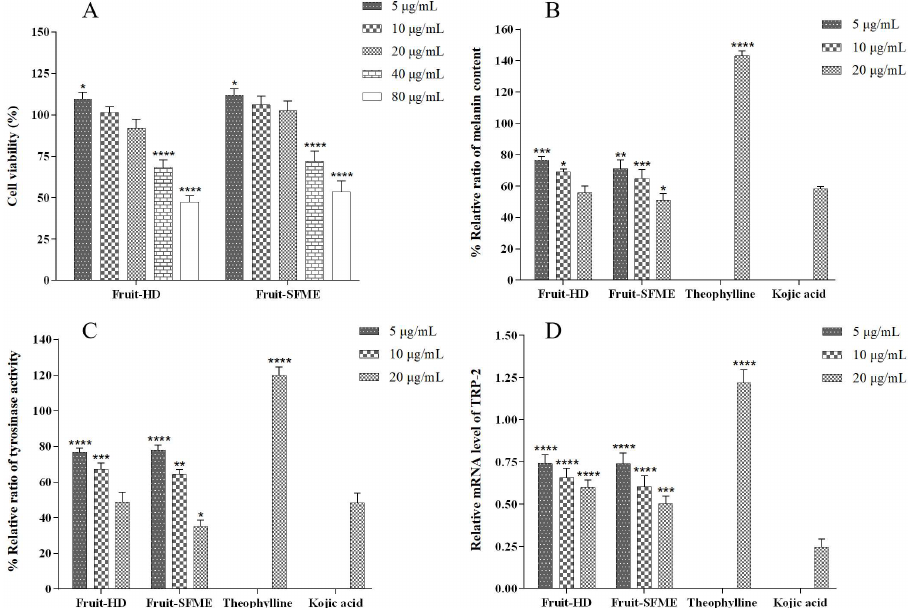
Figure 7. Melanogenesis assay in B16-F10 melanoma cells: ( A ) cytotoxicity assay in B16-F10 melanoma cells treated with L. cubeba fruit essential oils at 5–80 µ g/mL. The asterisk * indicates a significant difference from the control (* p < 0.05, **** p < 0.0001); ( B ) percentage of relative ratio of melanin content, ( C ) tyrosinase activity, and ( D ) relative mRNA level of TRP-2 in B16-F10 melanoma cells treated with essential oils, theophylline, and kojic acid at 5–20 µ g/mL. The asterisk * indicates a significant difference from the kojic acid (* p < 0.05, ** p < 0.01, *** p < 0.001, and **** p < 0.0001). The non-cytotoxic concentrations of L. cubeba essential oil were further used to evaluate the anti-melanogenesis effect in B16–F10 melanoma cells. Theophylline (pigment stimulator) and kojic acid (pigment inhibitor) at the non-cytotoxic concentration of 20 μg/mL were employed as the positive and negative controls, respectively. The percentage of the relative ratio of melanin content, tyrosinase activity, and relative mRNA level of TRP-2 in B16F10 melanoma cells treated with various concentrations of samples is illus- trated in Figure 7. The inhibitory effect of L. cubeba essential oil on melanin content ap- peared to be in the concentration-dependent manner as well (Figure 7B). A decreased mel- anin content was observed with the increase in concentration of L. cubeba essential oils from 5–20 μg/mL. The percentages of melanin content for theophylline and kojic acid were 143.14 ± 2.47 and 58.32 ± 1.08%, respectively. Although no significant difference was found in the inhibitory activity of L. cubeba essential oil and kojic acid on melanin formation, the inhibitory activity of SFME essential oil from July at 20 μg/mL was significantly higher than that of HD essential oil with a relative ratio of melanin content of 50.99 ± 3.34%. The tyrosinase activities and TRP-2 mRNA expression of cells treated with L. cubeba essential oil, theophylline, and kojic acid were correlated with the effect on melanin con- tent (Figure 7C,D). The enzymatic activities of melanogenesis in cells treated with theo- phylline and kojic acid were related to their effects on melanin formation [35]. Theophyl- line showed an increased activity of the tyrosinase and mRNA level of TRP-2 to 119.88 ± 3.77% and 1.22 ± 0.06, respectively. On the contrary, the tyrosinase activity and TRP-2 mRNA level for kojic acid were 48.39 ± 4.35% and 0.25 ± 0.04, respectively. The significant decrease in the tyrosinase activity and mRNA level of TRP-2 was observed in samples treated with L. cubeba essential oil at 5, 10, and 20 μg/mL. HD and SFME essential oils from July appeared to significantly decrease the tyrosinase activity to 48.94 ± 4.42% and 35.17 ± 2.79%, respectively, which corresponded to their mRNA levels of TRP-2 (0.60 ± 0.03, 0.50